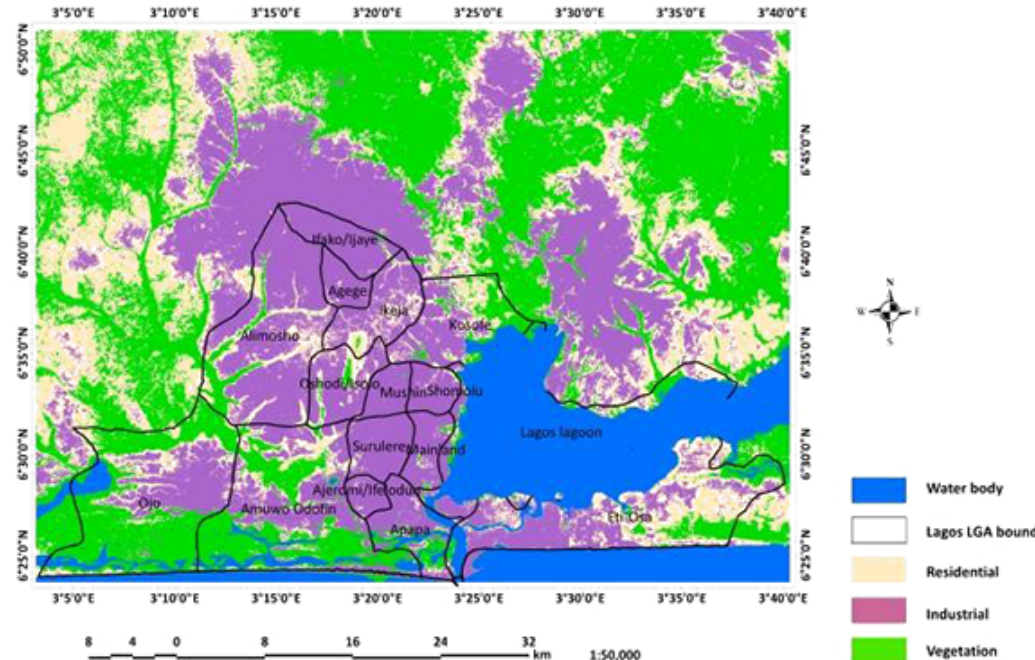
Figure 6. 2012 Land use (LU) and Land Cover (LC) map of the Lagos metropolis of Nigeria. Source: Nkwunonwo (2013).